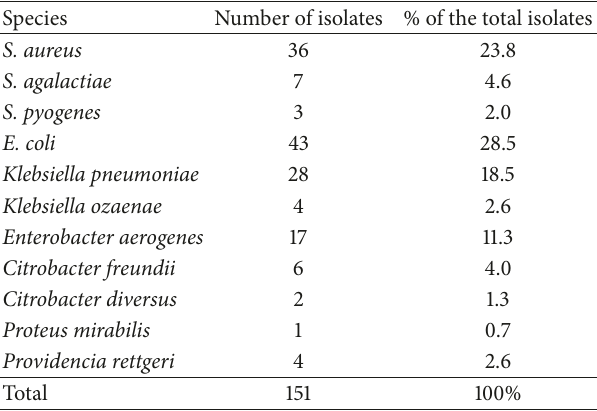
Table 2: Distribution of bacterial isolates ( 𝑛 = 151 ). Species Number of isolates % of the total